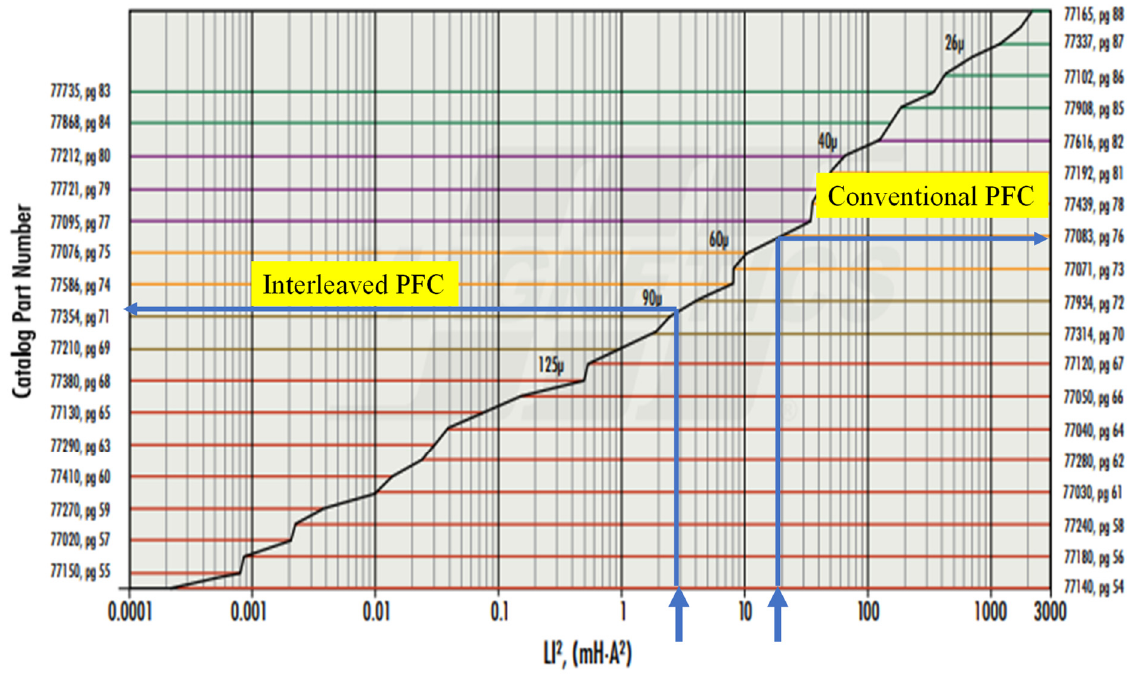
Figure 4. Boost inductor core selection for the conventional and the interleaved PFC topologies.